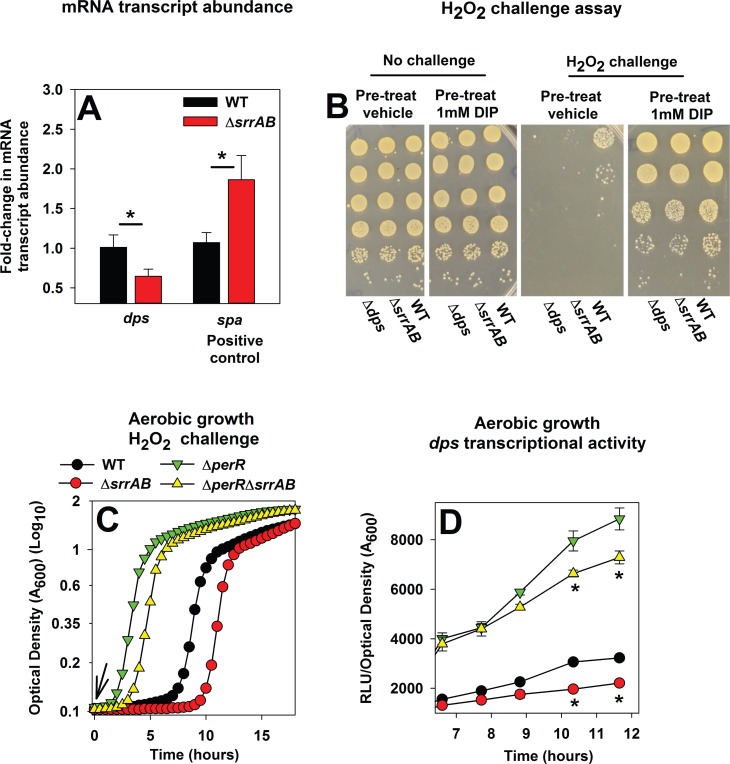
SrrAB positively influences Dps expression and iron chelation or introduction of a ΔperR allele alleviates the deficient survival of a ΔsrrAB mutant upon H2O2 challenge.Panel A; The abundance of the dps transcript is lower in the ΔsrrAB strain. The abundances of the dps and spa transcripts were determined in the WT (JMB1100) and ΔsrrAB (JMB1467) strains from the cDNA libraries described in Fig 1E. The data were normalized to 16s rRNA transcript levels and are presented as fold-change relative to the WT. Panel B; Pre-incubation of the ΔsrrAB and Δdps strains with a metal chelator alleviates their sensitivity towards H2O2 challenge. The WT, ΔsrrAB, and Δdps (JMB2092) strains were cultured aerobically and subsequently incubated in buffer with vehicle control or 1 mM 2,2 dipyrydyl. Cells were then challenged with H2O2 and survival was determining colony-forming units (CFU). Panel C; Introduction of a ΔperR allele mitigates the H2O2 sensitivity phenotype of the ΔsrrAB strain. The WT, ΔsrrAB, ΔperR (JMB2151), and ΔperR ΔsrrAB (JMB2615) strains were diluted into TSB and challenged with 1.57 mM H2O2 at the point of inoculation (indicated by arrow). Panel D; SrrAB and PerR influence dps transcriptional activity independent of one another. The transcriptional activity of dps was assessed in the WT, ΔsrrAB, ΔperR and ΔperR ΔsrrAB strains containing gfp under the transcriptional control of the dps promoter (pCM11_dps). Representative data are displayed in Panels B and C and experiments were performed on least three independent occasions. Data in Panels A and D represent the average of biological triplicates with standard deviations shown. Two-tail student t-tests were performed on the data in Panel A and * represents statistically significant data with P< 0.05.